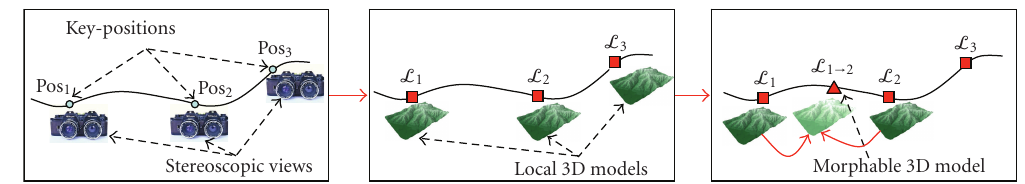
Figure 1: Initially, a sparse set of stereoscopic views is captured at key-positions along the path. Based on these stereoscopic views, a series of local 3D models is then constructed. As the user traverses the path, a morphable 3D model is displayed during rendering. In this manner, a continuous morphing between successive local models takes place at any time, with this morphing being both photometric as well as geometric.